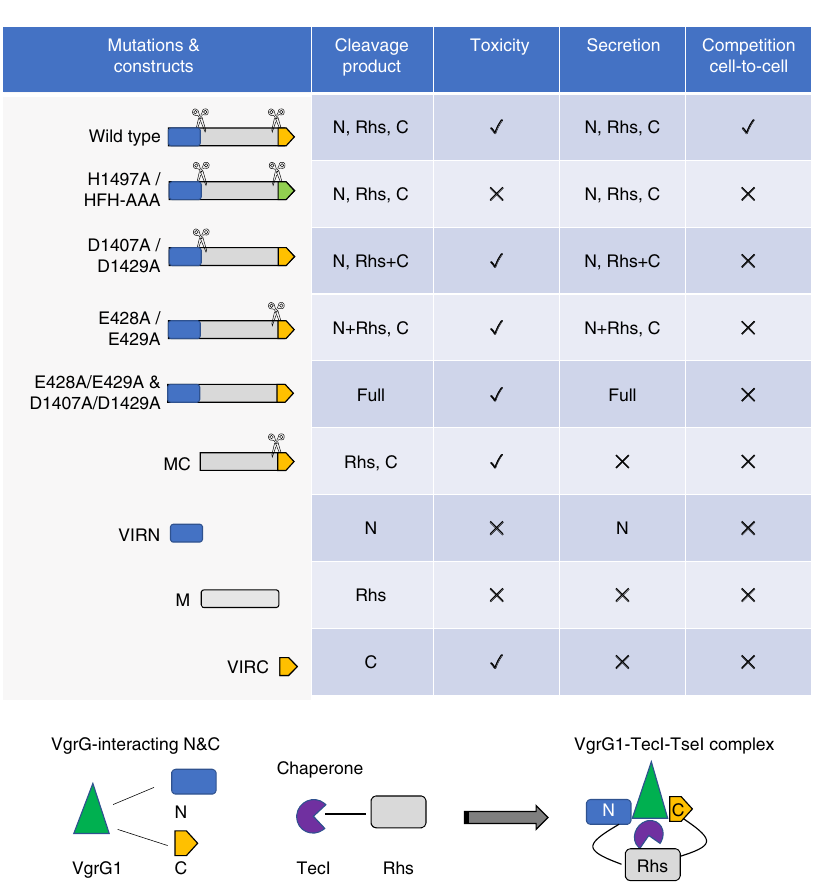
Fig. 5 Cleavage of TseI homologs. a Maximum-likelihood phylogeny of select sequences including previously published Rhs proteins. Phylogeny was constructed using IQ-TREE web server with bootstrap 1000 times and values indicated. Proteins experimentally tested in this study are highlighted in blue in a and b . b Alignment of the N-terminal and the C-terminal cleavage regions of Rhs proteins. Red triangle indicates cleavage site and red arrow indicates mutation sites that abolish cleavage. c Operon structure and toxicity of PSPTO_5438. PSPTO_5438, and its predicted immunity gene were cloned to pET28a. Survival of E. coli BL21(DE3) expressing PSPTO_5438 alone or together with immunity was compared on plates containing glucose (repression) or IPTG (induction) with 10-fold serial dilutions. d Critical residues that abolish PSPTO_5438 cleavage. N-terminal His-tagged PSPTO_5438 and mutant proteins were co-expressed with untagged immunity proteins, puri fi ed with nickel columns, and compared by SDS-PAGE analysis. Mutations D1385A and D1407A inhibited cleavage of the C-terminal while E413A inhibited N-terminal cleavage, resulting in enriched accumulation of Rhs + C and Rhs + N fragments. E412A attenuated but did not fully block N-terminal cleavage. e C-terminal cleavage of PA2684 detected by western blotting analysis. PA2684 was expressed with a C-terminal FLAG tag in the periplasm (Tat-signal added) and in the cytoplasm of E. coli , respectively. C-terminal cleavage was detected in both samples. f Comparison of puri fi ed VP1517 and its mutants. C-terminal His-tagged VP1517 and its mutants were expressed and puri fi ed with a nickel column. WHH-AAA refers to three amino acid mutations of tryptophan, histidine, and histidine (from 1328 to 1330) to alanine that inactivate the toxicity of VP1517. Mutation H1354A also abolished toxicity. Mutation D1105A inhibited the C-terminal cleavage of the VP1517 H1354A mutant. Cleavage of these proteins was con fi rmed by western blotting analysis in Supplementary Fig. 9D. Source data are provided as a Source Data fi le. Data in c – f are representative of at least two replications.